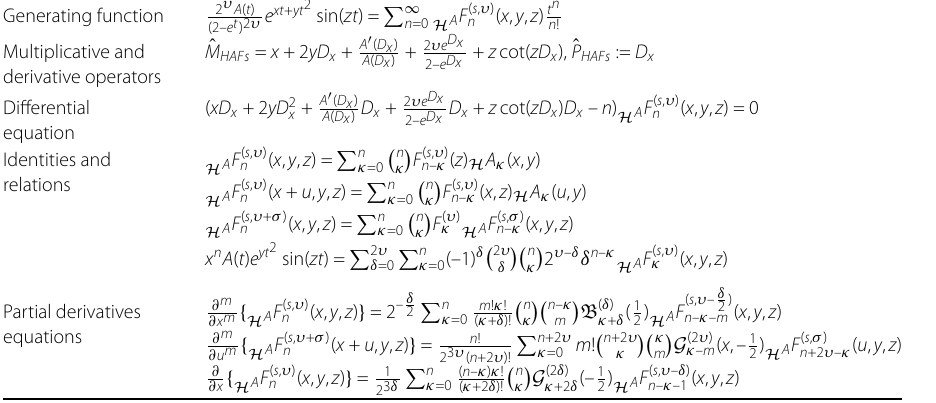
F ( s , υ ) n ( x , y , z ) H A υ A ( t ) e xt + yt 2 sin( zt ) = (2– et )2 υ